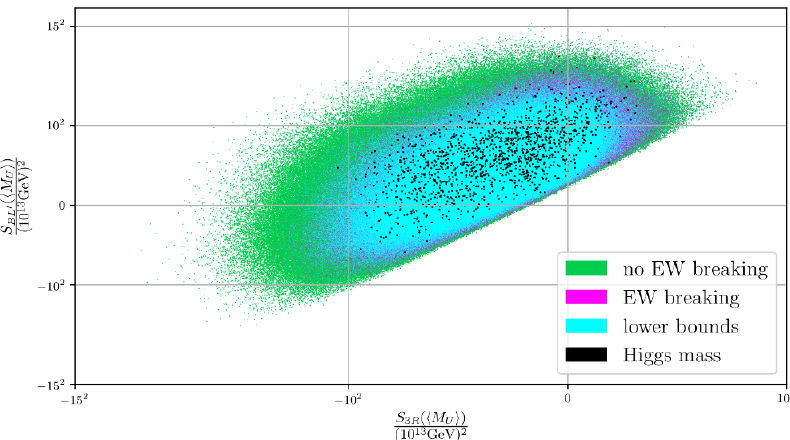
Figure 3. Results from generating 50 million sets of initial data where m 2 cosmological constraint. We (cid:12)nd that 4,209,300 points break B - L but not electroweak symmetry, and 860,084 points appropriately break both B - L and electroweak symmetry. Of the latter, 545,753 points are consistent with current LHC bounds on sparticle searches. Finally, we have 1406 points which satisfy all these conditions and are within the 2 (cid:27) window of the measured Higgs mass. The black points are enlarged for legibility.The axes are two dominant parameters of the renormalization group equations and are de(cid:12)ned in